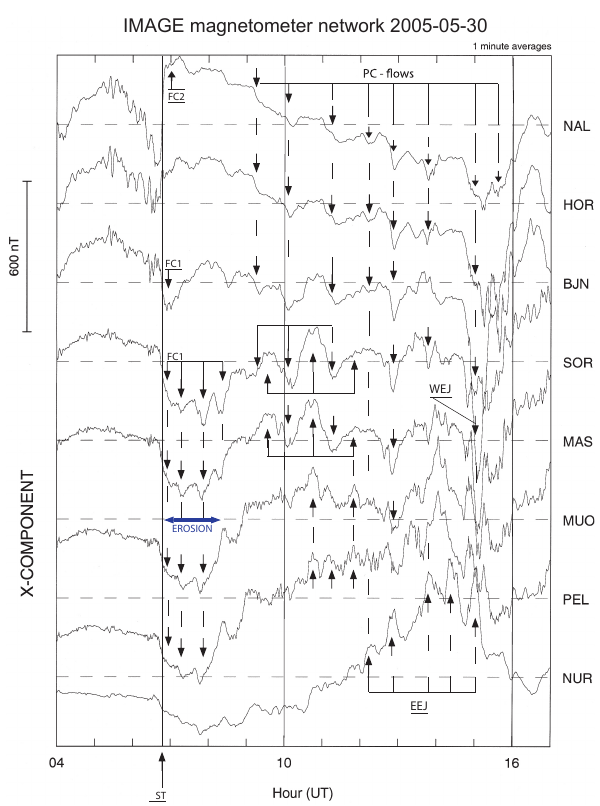
Fig. 4. X-component magnetic deflections from ground stations in Svalbard – Scandinavia – Finland during the interval 04:00– 17:00UT (30 May 2005), ordered by decreasing latitude: NAL (75.2 ◦ MLAT), HOR (74.1 ◦ MLAT), BJN (71.4 ◦ MLAT), SOR (67.3 ◦ MLAT), MAS (66.2 ◦ MLAT), MUO (64.7 ◦ MLAT), PEL (63.6 ◦ MLAT), and NUR (56.9 ◦ MLAT). Magnetic effects related to specific flow features and electrojet currents have been marked. See text for